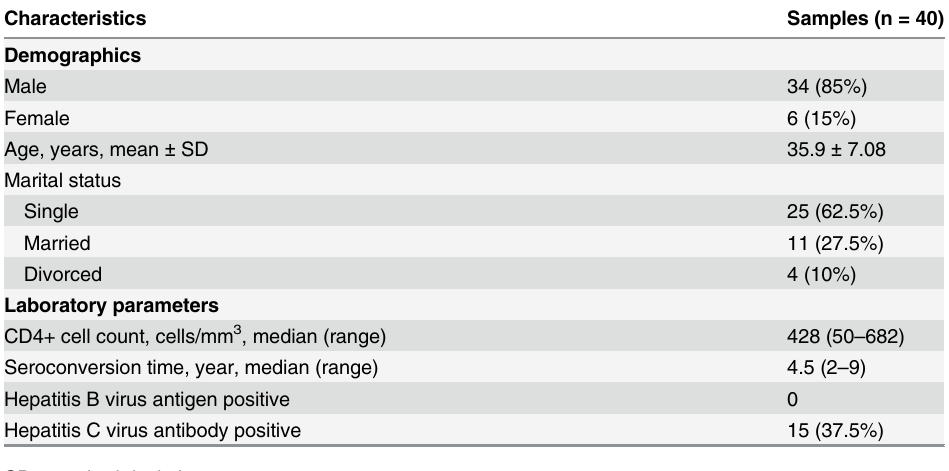
Table 1. Demographics and laboratory data of study